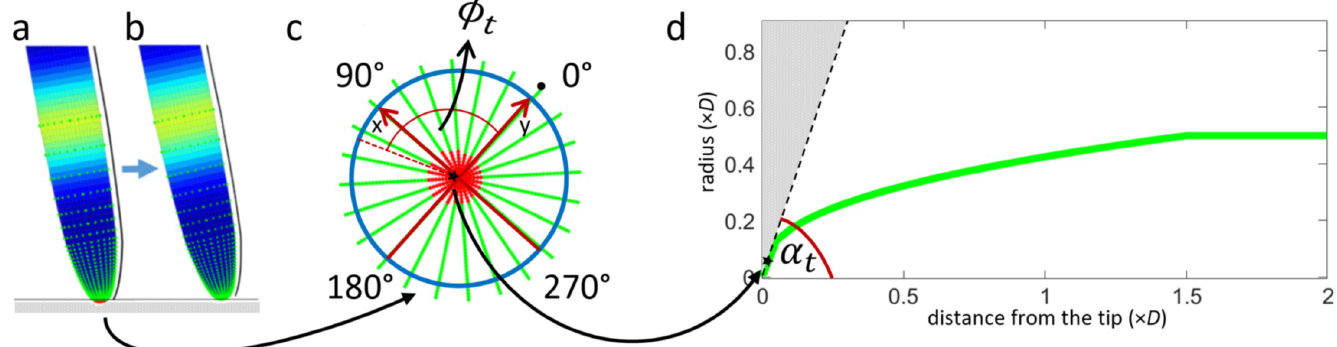
Fig 3. Modeling of thigmotropism. (a) An example of root apex intersecting with an obstacle depicted by a horizontal gray line. The root is covered with tactile sensory points, colored in green when no intersection is detected and colored in red when an intersection is detected (e.g., here at the very tip). A black line depicts the reference curve. (b) The corrected root (a) after a minimalistic bending to remove the intersection with the obstacle. (c) Tactile sensory points, shown from the bottom (tip) view on the root, are equidistantly spaced w.r.t. the center of the root in this view. The points are located at different angles ϕ w.r.t. the reference curve ( ϕ = 0, black dot) depicted by the black line in (a, b). The mean of the intersected (red) points depicted by a black star represents an estimated location of the occurred touch. (d) The root shape is defined by a green line which illustrates how the root ( y -axis) radius changes as a function of the distance from the tip ( x -axis). x and y represent the multiplier for D as unitary value. Knowing the position of the mean of the activated sensory points (black star) is sufficient to estimate the α (represented in the figure with the light gray triangle) as the angle between the centerline of the root and the tangent (dashed black line) at the starred point.